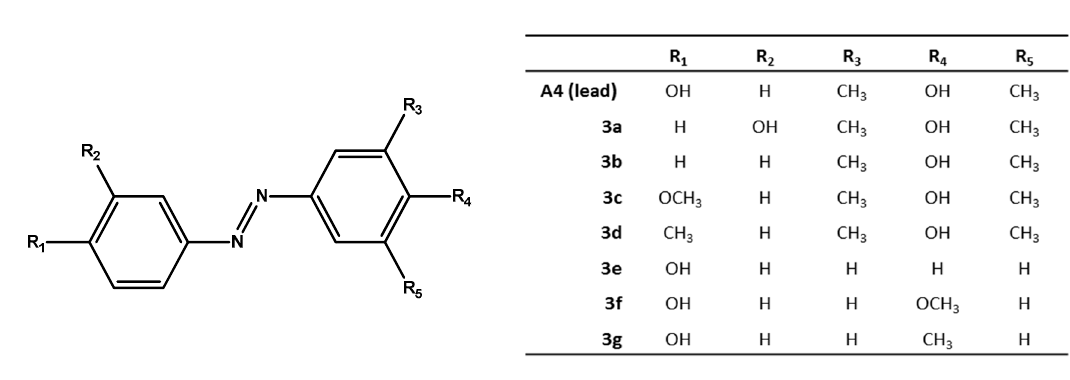
Figure 1. Substituted-(phenyldiazenyl)phenol derivatives 3a – g .